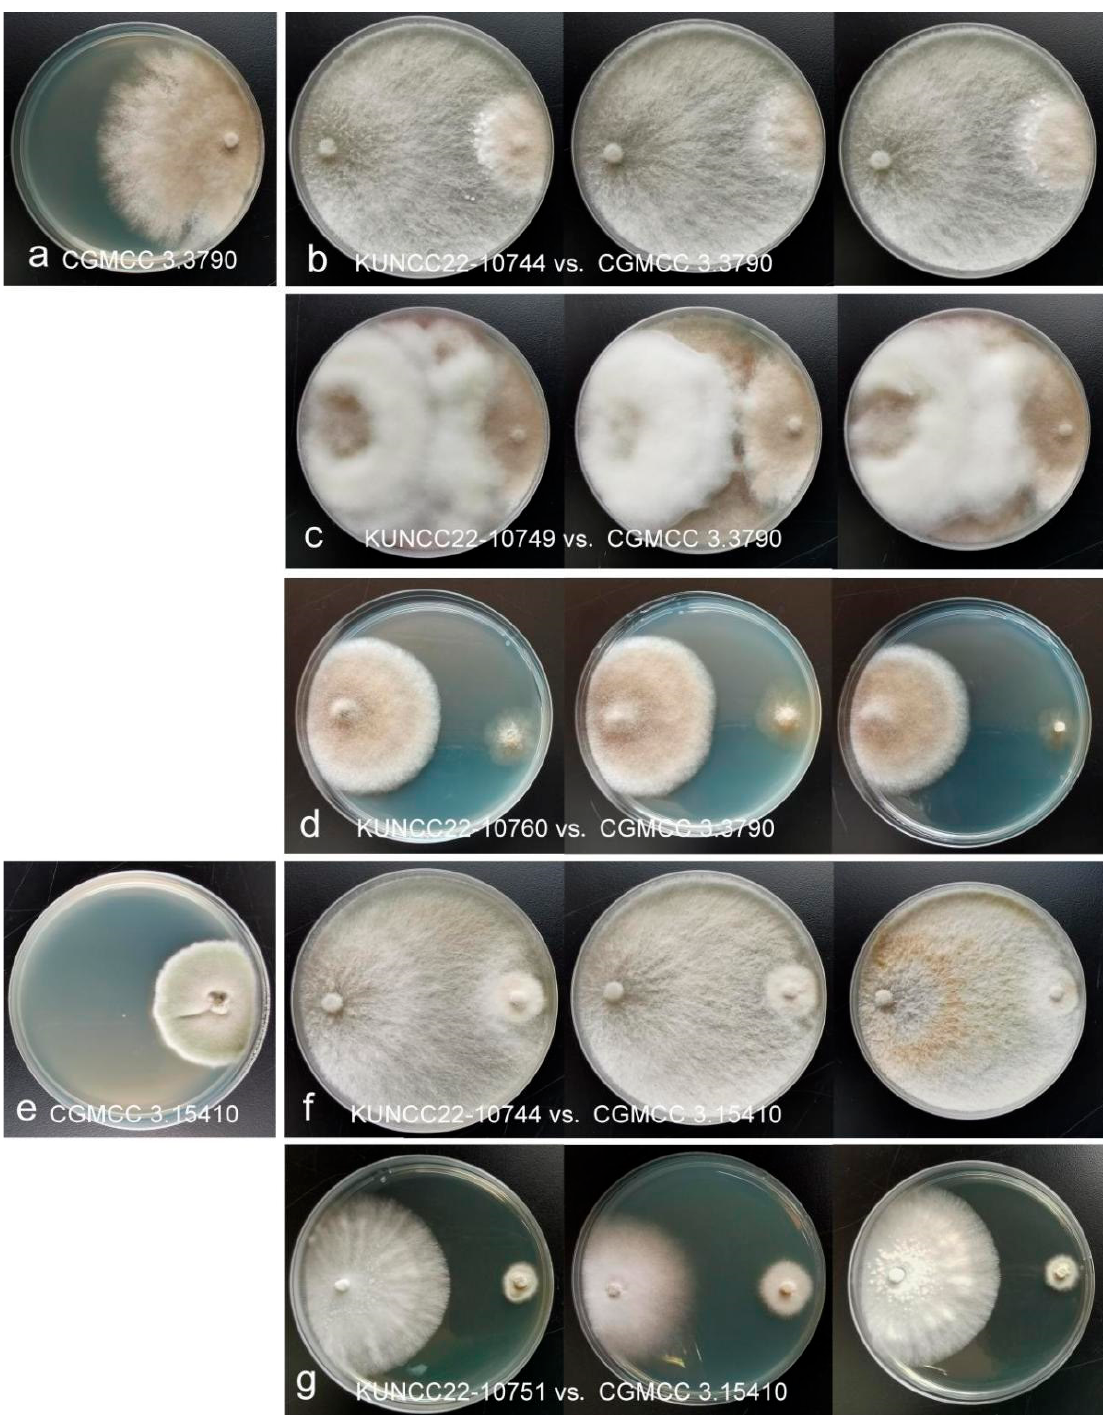
Figure 5. The two fungal pathogens co ‐ cultivated with the mango fungal endophytes on PDA plates. ( a , e ) Control groups; ( b – d , f , g ) Endophyte ‐ phytopathogen antagonism tests.